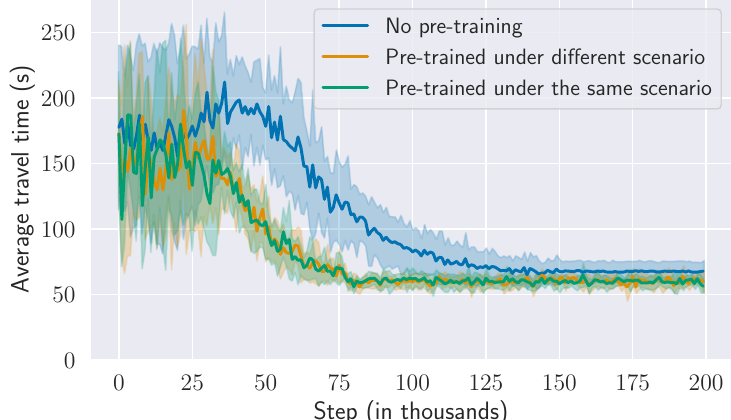
Figure 6. Convergence speed of traffic inference